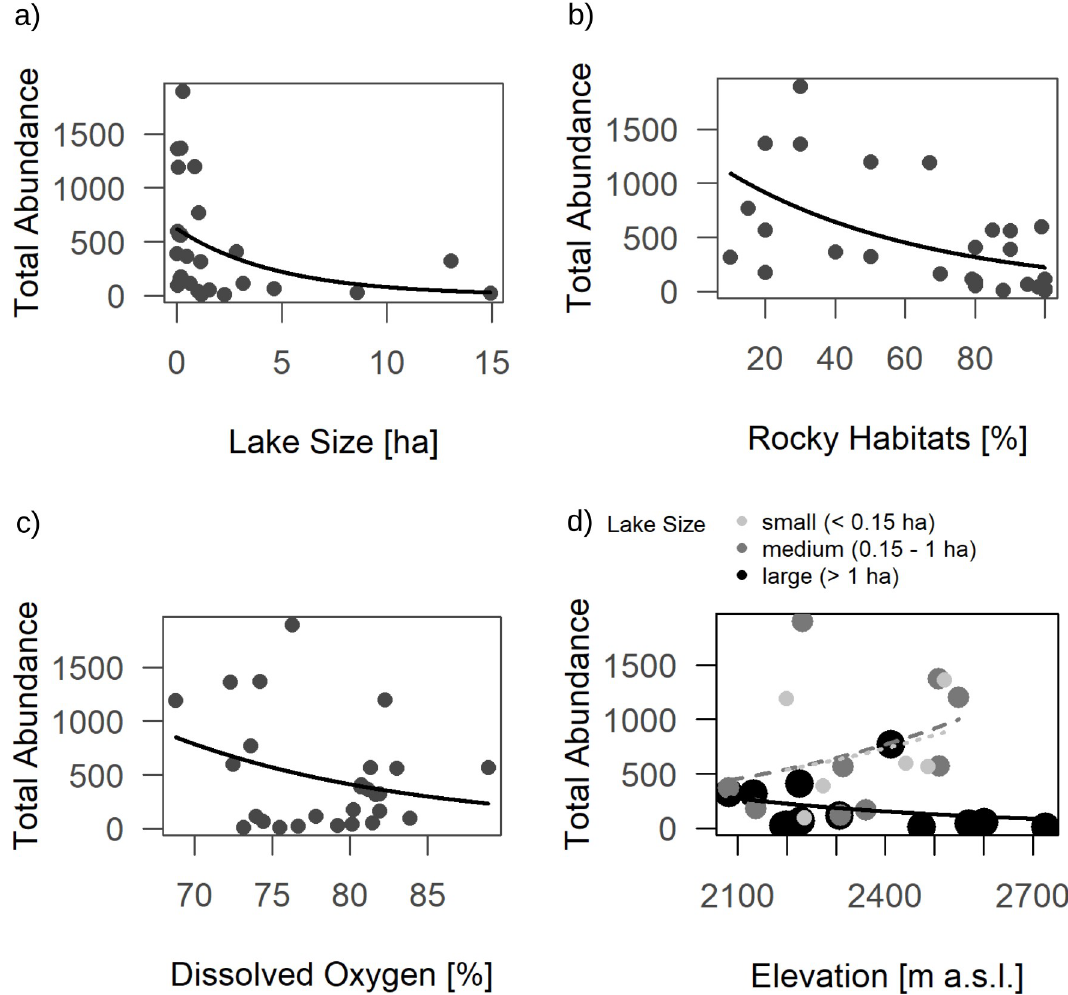
Fig 2. Effect of total macroinvertebrate abundances in alpine lakes and a) lake size; b) proportion of rocky habitats (sum of small rocks and sheer rock faces/boulders); c) dissolved oxygen and d) the interaction of elevation and lake size, where lake size is visualized by varying shades of grey and different regression lines as well as size of the symbols. Regression lines from generalized linear regression with quasipoisson distributions and log-links. All effects shown here are significant (Table